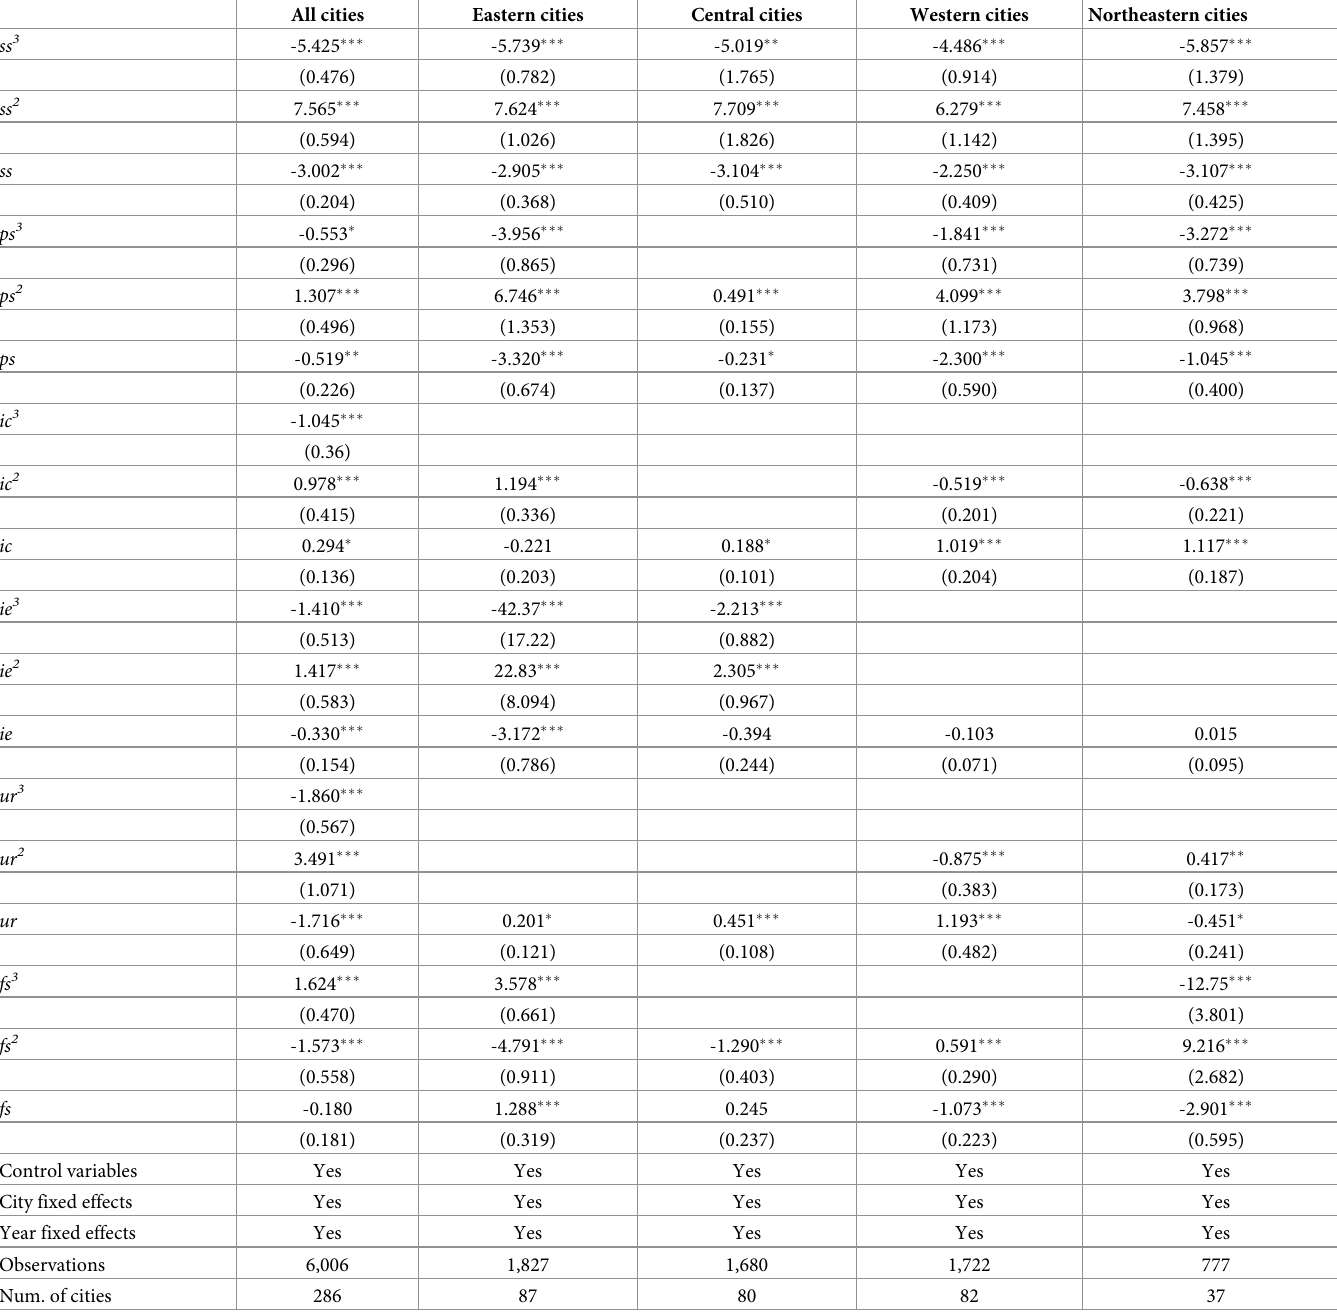
Table 3. Results of Eq (37) (dependent variable: lnrpgdp